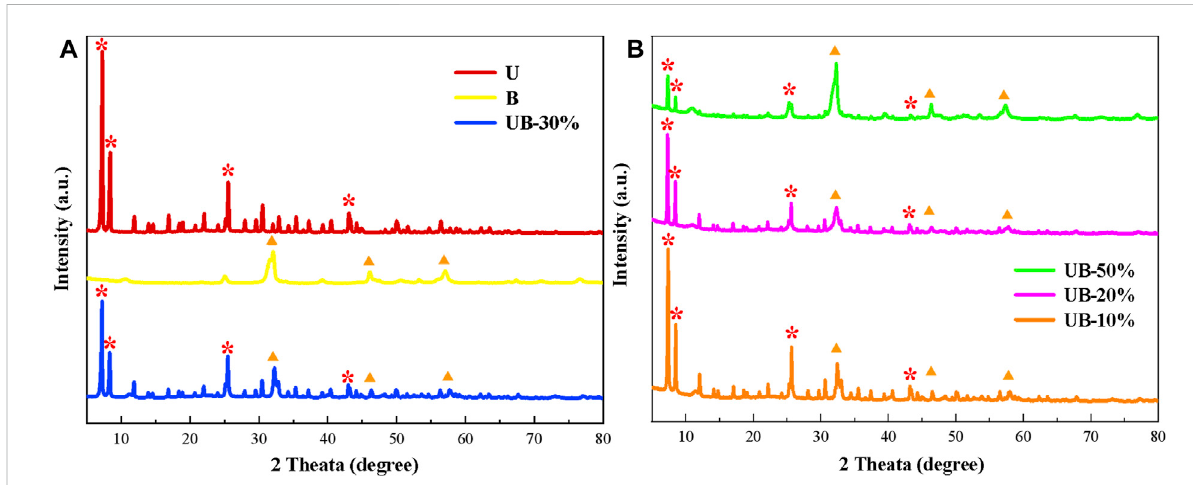
FIGURE 1 XRD patterns of U, B, UB-10%, UB-20%, UB-30% and UB-50%